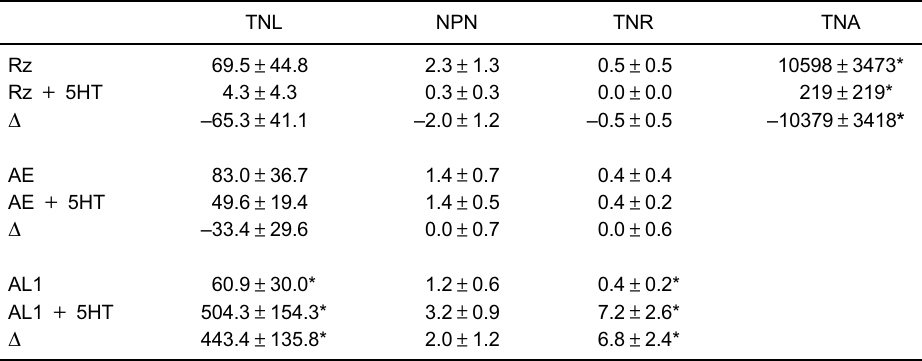
Table 1. Changes in morphological parameters induced by serotonin